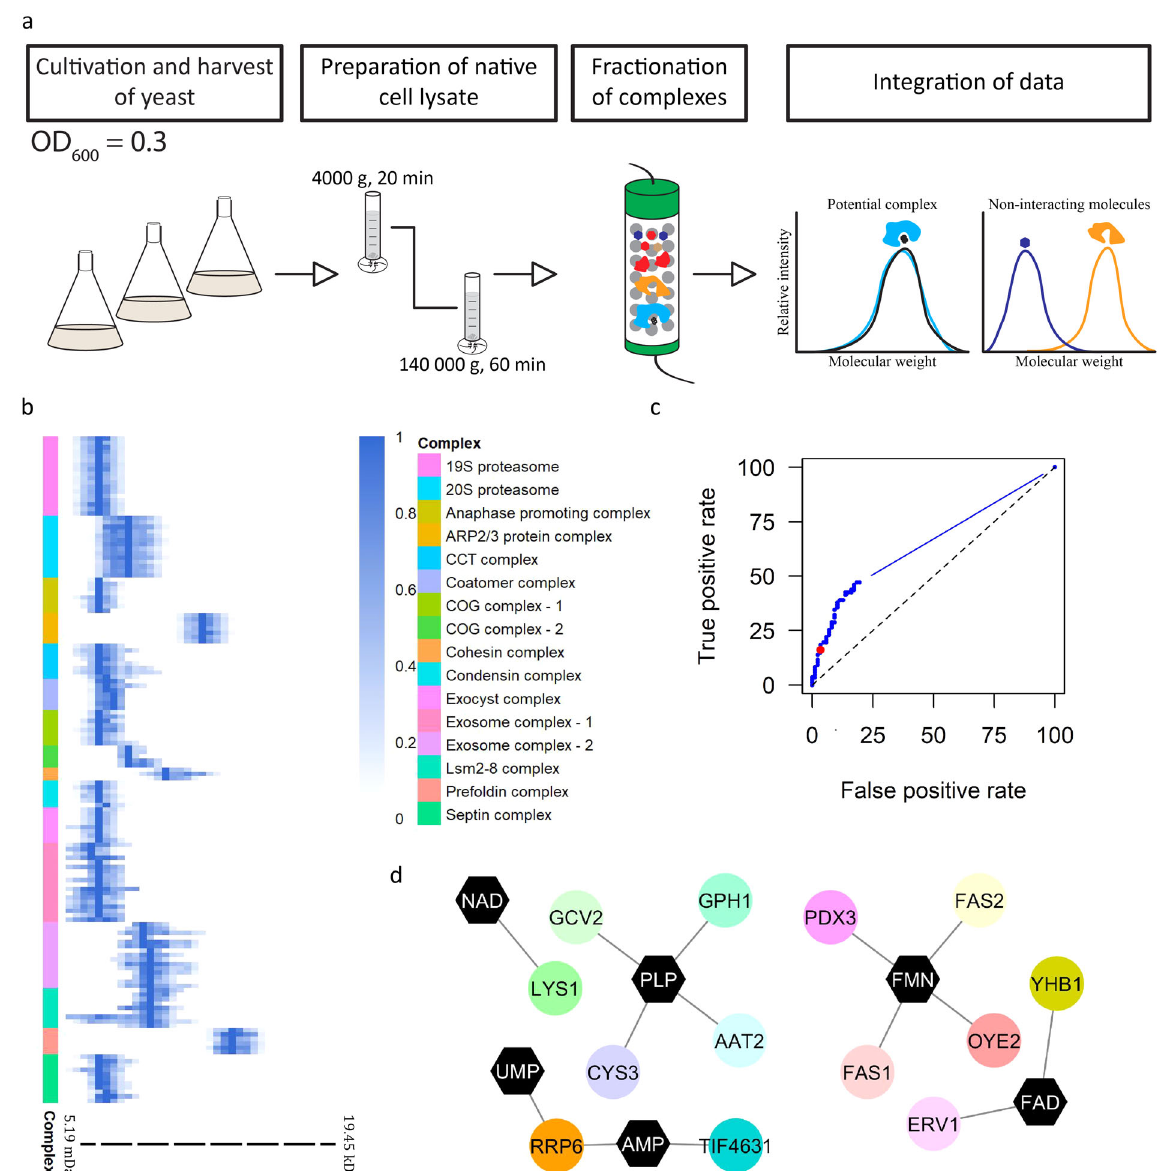
Fig. 1 PROMIS allows for system-wide detection of protein – small molecule and protein – protein complexes using size exclusion chromatography. a Dividing yeast cells were harvested in the logarithmic phase of growth and were used as a source of endogenous protein – protein and protein – metabolite complexes. Complexes were fractionated using size exclusion chromatography, lyophilised and subjected to methyl tert-butyl ether-methanol-water extraction. Polar metabolites and proteins were analysed by liquid chromatography-mass spectrometry. b Known yeast protein macro-complexes remain intact. Multiple subunits of known protein macro-complexes co-elute together. The peak elution pro fi les of the components of 14 known protein macro- complexes are depicted (Supplementary Data S7 and S8). The intensity was calculated relative to the maximum intensity of a given protein measured across size exclusion chromatography separation range. Distinct colours are used to mark different protein macro-complexes. c The receiver operating characteristic curve represents a trade-off between numbers of captured true-positive and false-positive protein – metabolite interactions by varying the Pearson correlation coef fi cient (PCC) (Supplementary Data S10). The red dot indicates the chosen threshold (PCC ≥ 0.7) used for determining complexes. d Interaction network of captured known protein – metabolite complexes. Overall, 14 of the 87 known protein – metabolite interactions were re-captured in the PROMIS experiment (Supplementary Data